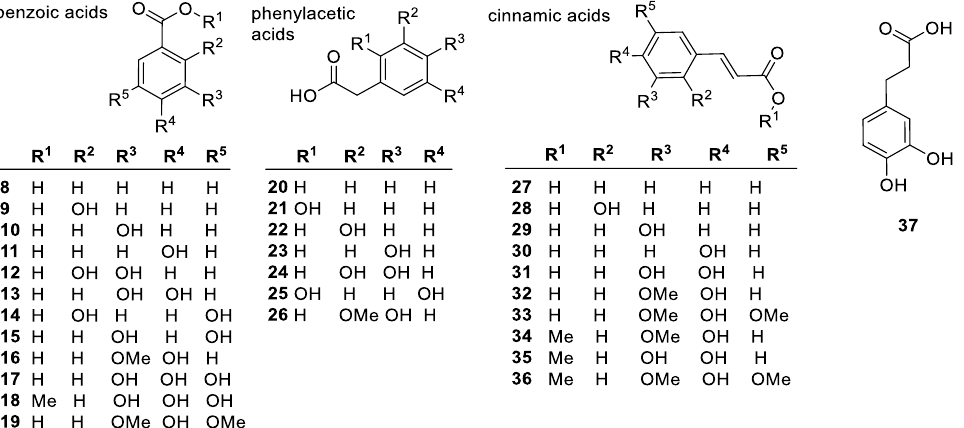
Figure 4. Structure of representative phenolic acid-type compounds with reported antioxidant ac- tivity. Phenylacetic acids contain a CH 2 link between the phenyl ring and the carboxylic acid group. As a result, the carboxylic acid group only influences the antioxidant activity through the mild inductive effect [89]. Since the -CH 2 COOH substituent is a weak elec- tron-donating group, the electron density over the phenyl ring increases somewhat, thus decreasing the bond dissociation energy (BDE) of the phenolic OH bond increasing the antioxidant activity of the compounds [90]. Gallic acid ( 17 ) is perhaps the most important of the phenolic acids due to its broad range of physiological effects, from antimicrobial, anti-inflammatory, and anti-cancer ac- tivity to its ability to prevent oxidative damage. Since it is partially hydrophobic, it shows